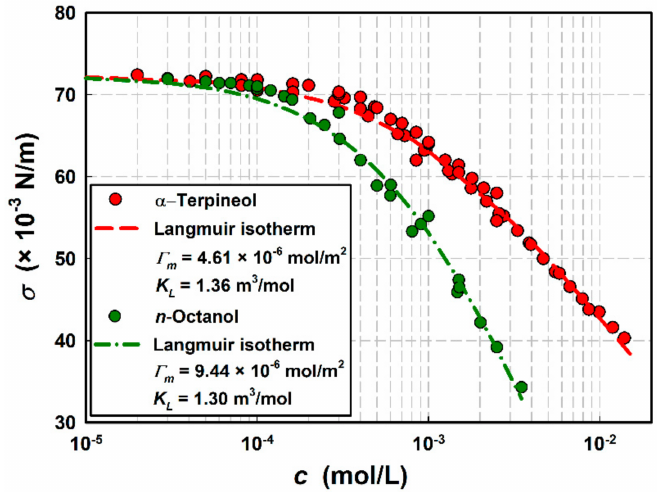
Figure 2. Surface tension in dependence on the concentration of surfactant. Evolution of Langmuir isotherm for solutions of both surfactants.